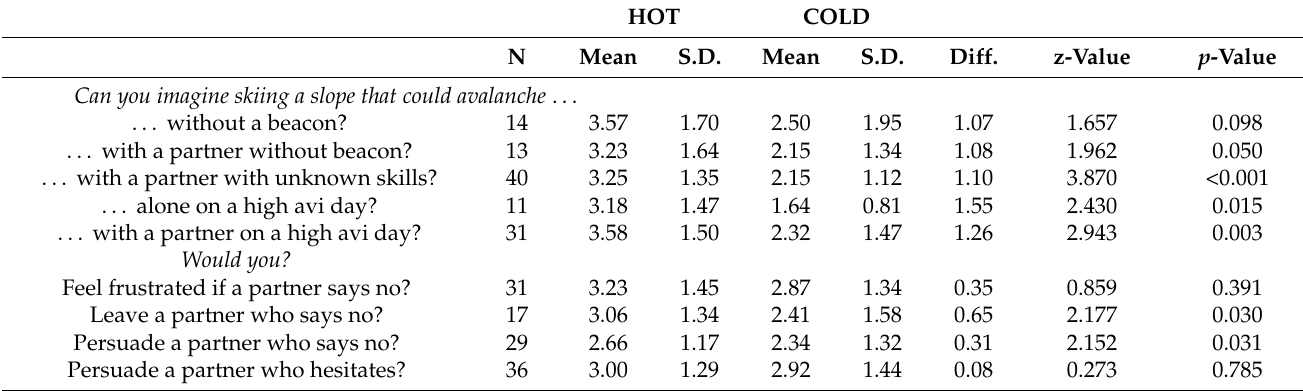
Table A1. Mean responses for participants who did not answer “No” in the hot state. Wilcoxon signed rank tests. HOT COLD N